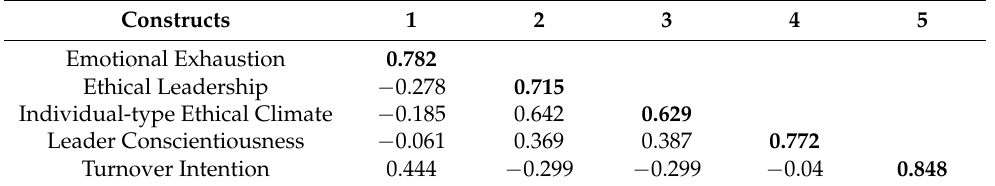
Table 1. Discriminant validity.